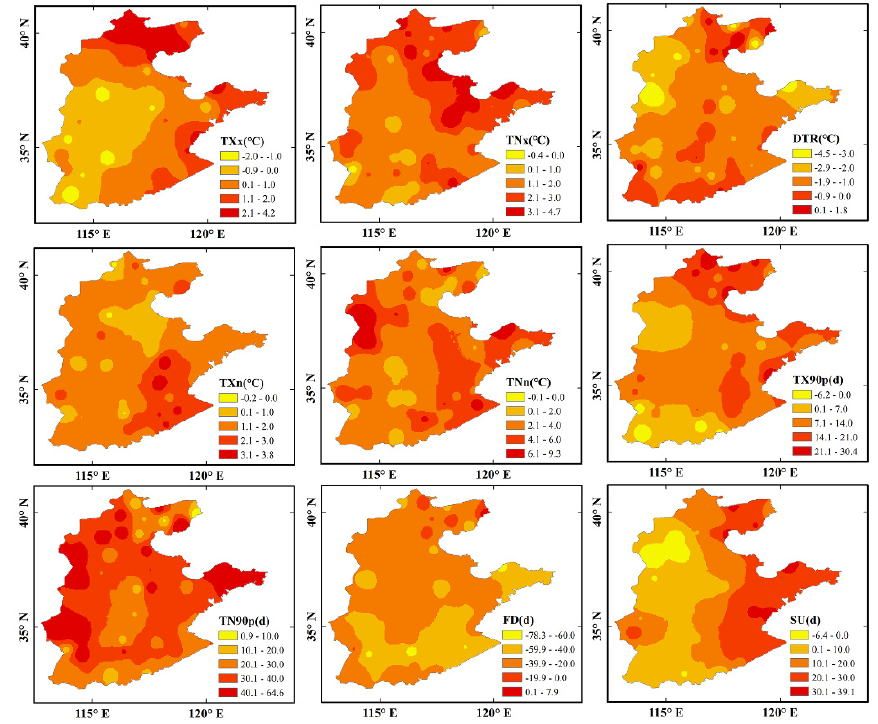
Figure 4. Spatial characteristics of extreme temperature indices in the North China Plain from 1971 to 2010.